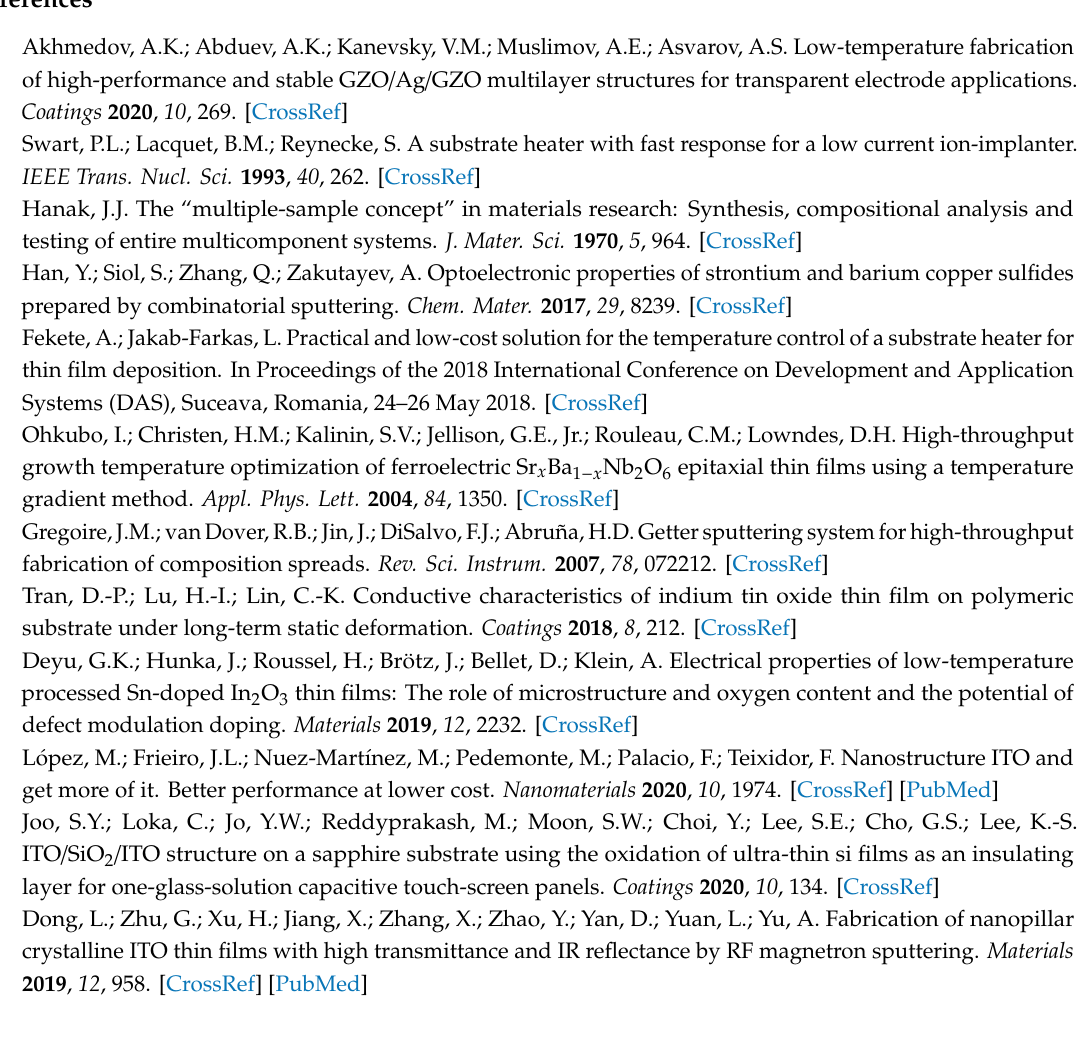
Figure S1: Photos of one of the heated holders of the MPDTA seen from di ff erent angles, Figure S2: Additional information about the vacuum electrical